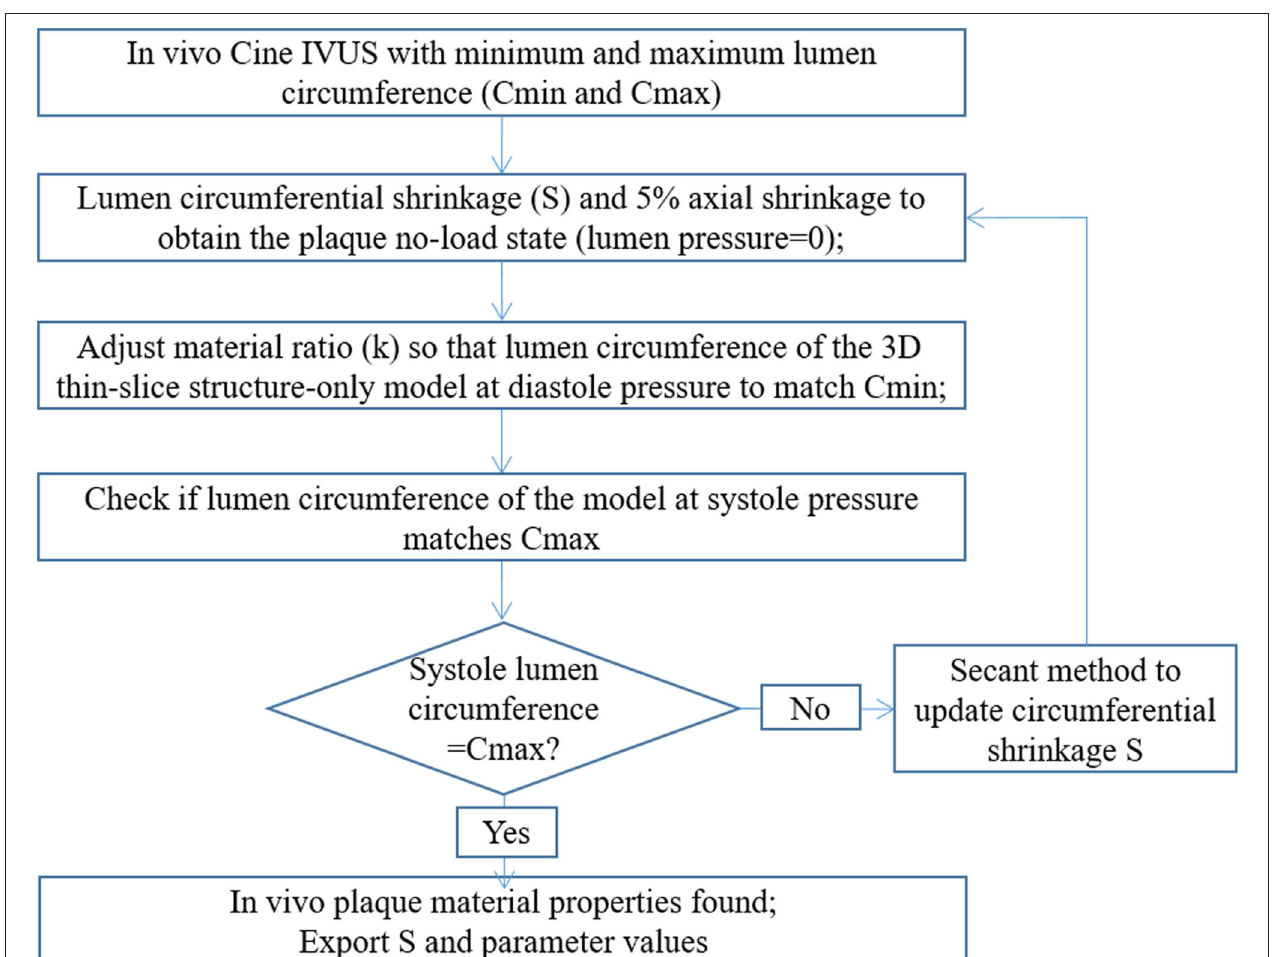
FIGURE 3 | Flowchart of the iterative scheme to quantify in vivo plaque material properties.